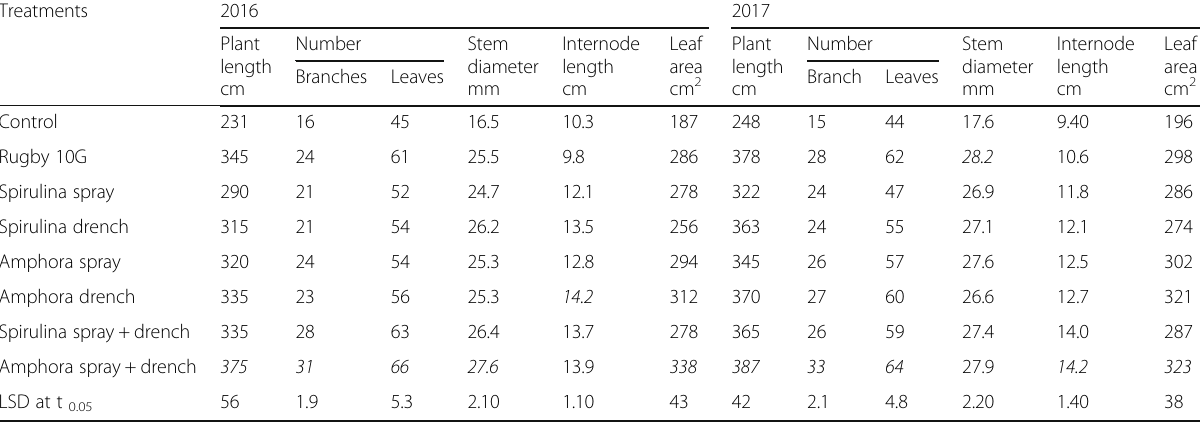
Table 1 Effect of algal treatments of cucumber Hesham hybrid compared with control and Rugby nematicide on vegetative growth under infested soil with root-knot nematodes in 2016 and 2017 seasons